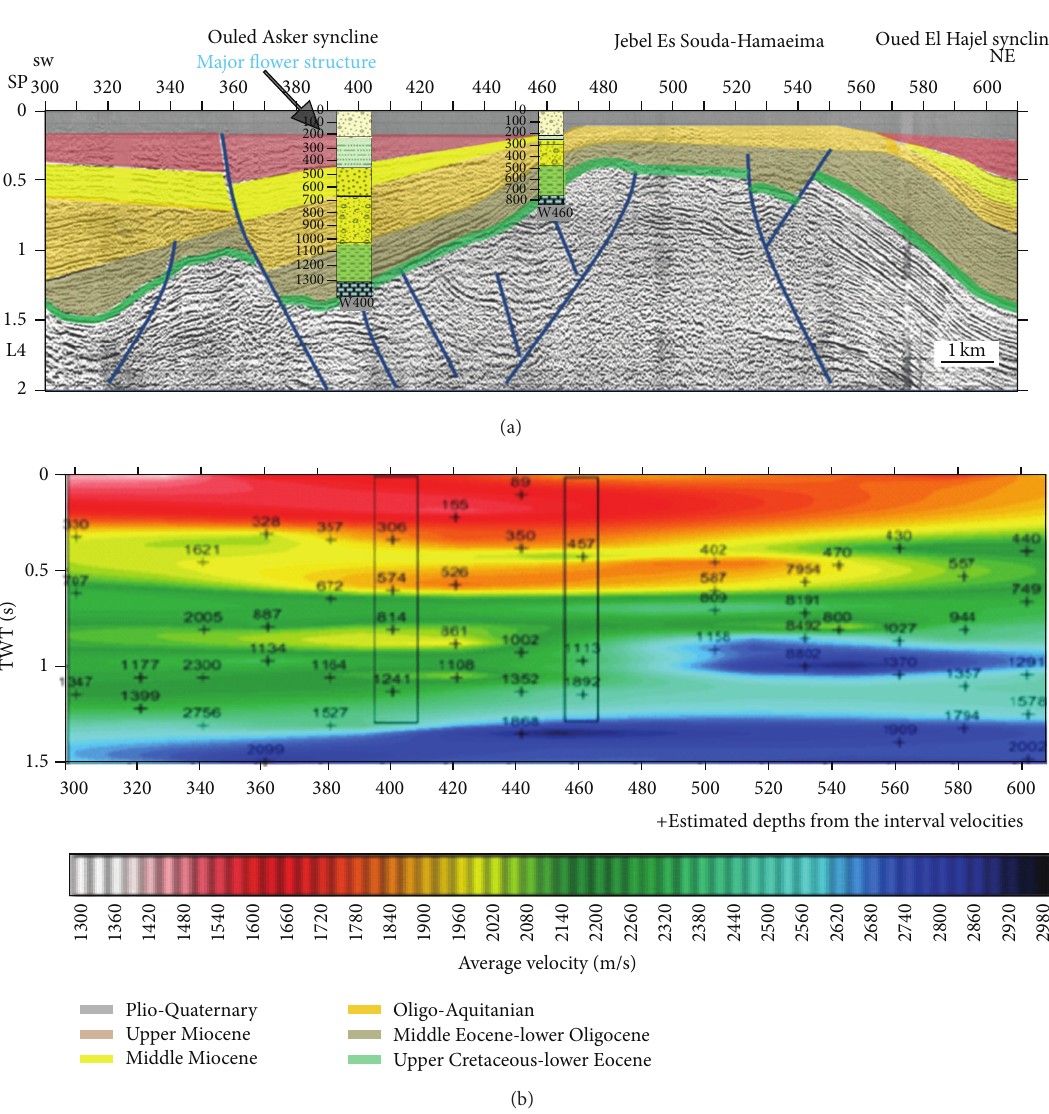
Figure 14: (a) W400 and W460 fictive wells associated with the L4 seismic line and (b) average velocity variation associated with L4 (black dashed line frame). (+) Depths estimated from the interval